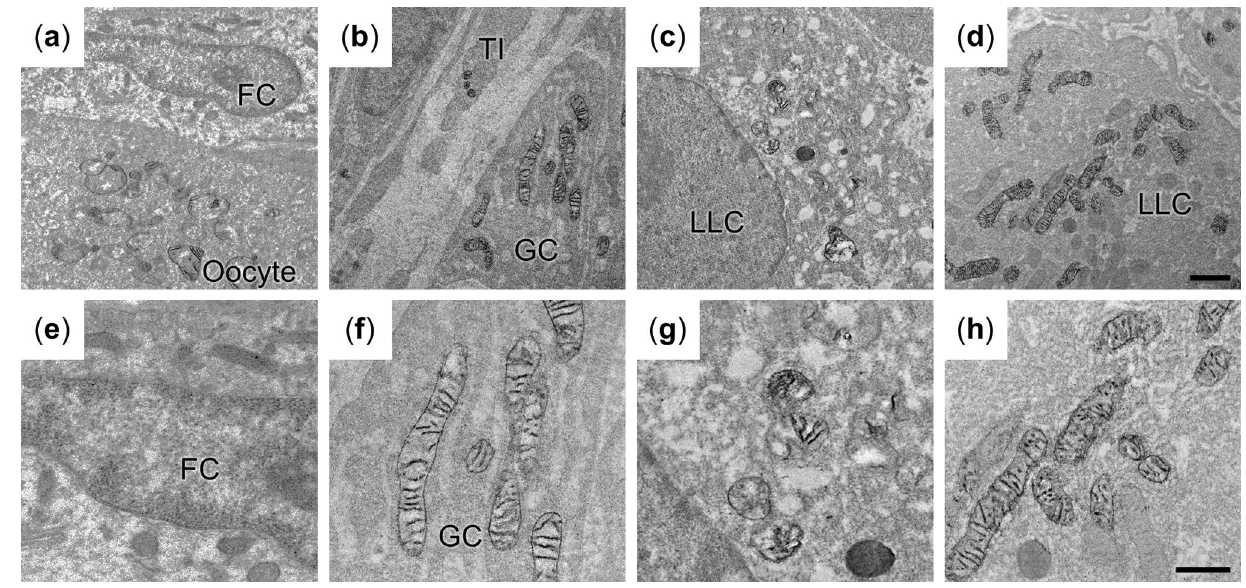
Figure 5. The distributions of COX signals in the goat LLC lineage. Images of COX signals (dark densities) were obtained at low ( a – d ) and high magnifications ( e – h ) in FC ( a , e ), GC ( b , f ), LLC in CH ( c , g ) and LLC in CL ( d , h ). TI theca interna cell. Bar: 1 μm ( a – d ) and 0.5 μm ( e – h